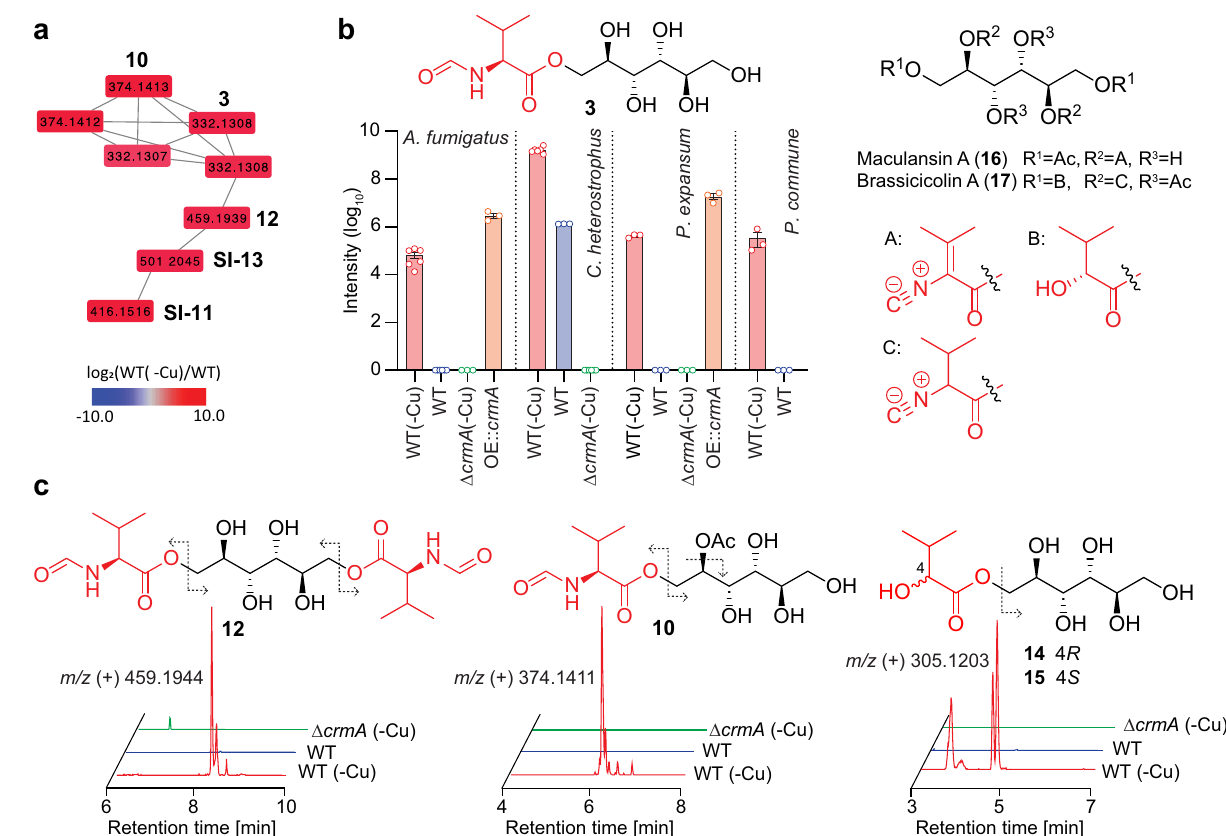
Fig. 3 | Identi fi cation of fumicicolin A and related metabolites. a Partial repre- sentation of MS2 network (cosine >0.7) for WT C. heterostrophus in ESI+, showing the cluster containing fumicicolin A ( 3 ) and the heterocicolins ( 10 – 13 ). Shown nodes are strongly upregulated in wildtype grown without copper (see Supple- mentary Fig. 4 for full network). b Relative abundance of fumicicolin A ( 3 ) in A. fumigatus , C. heterostrophus , and Penicillium spp ., and its structural similarity with known D -mannitolderivatives,maculansinA( 16 )andbrassicicolinA( 17 ). c ESI+ion